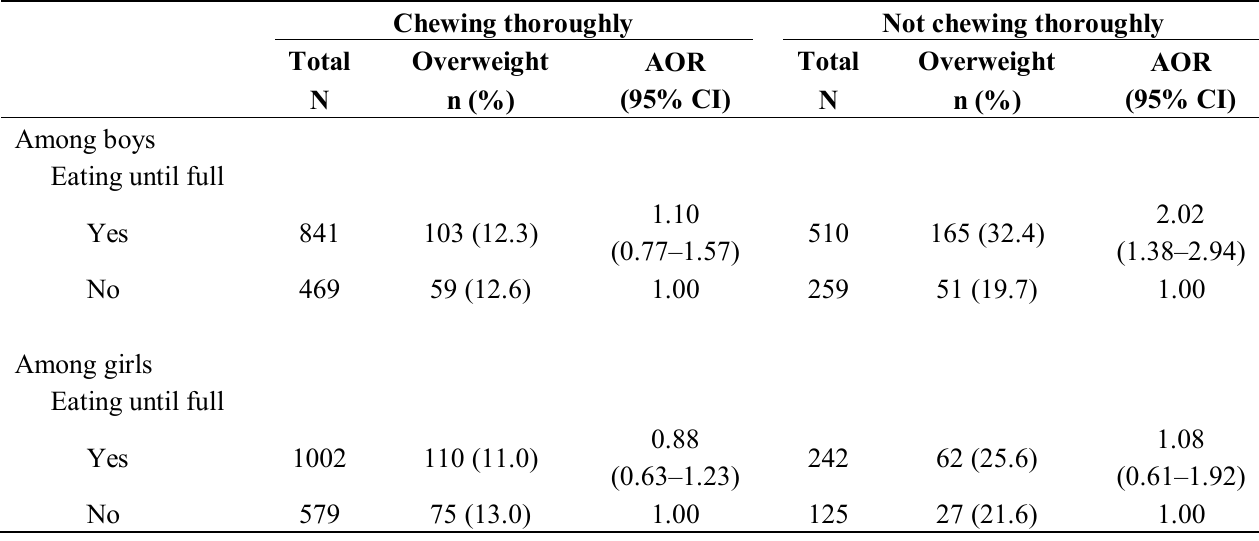
Table 4. Adjusted odds ratios of eating until full for being overweight by chewing thoroughly or not.